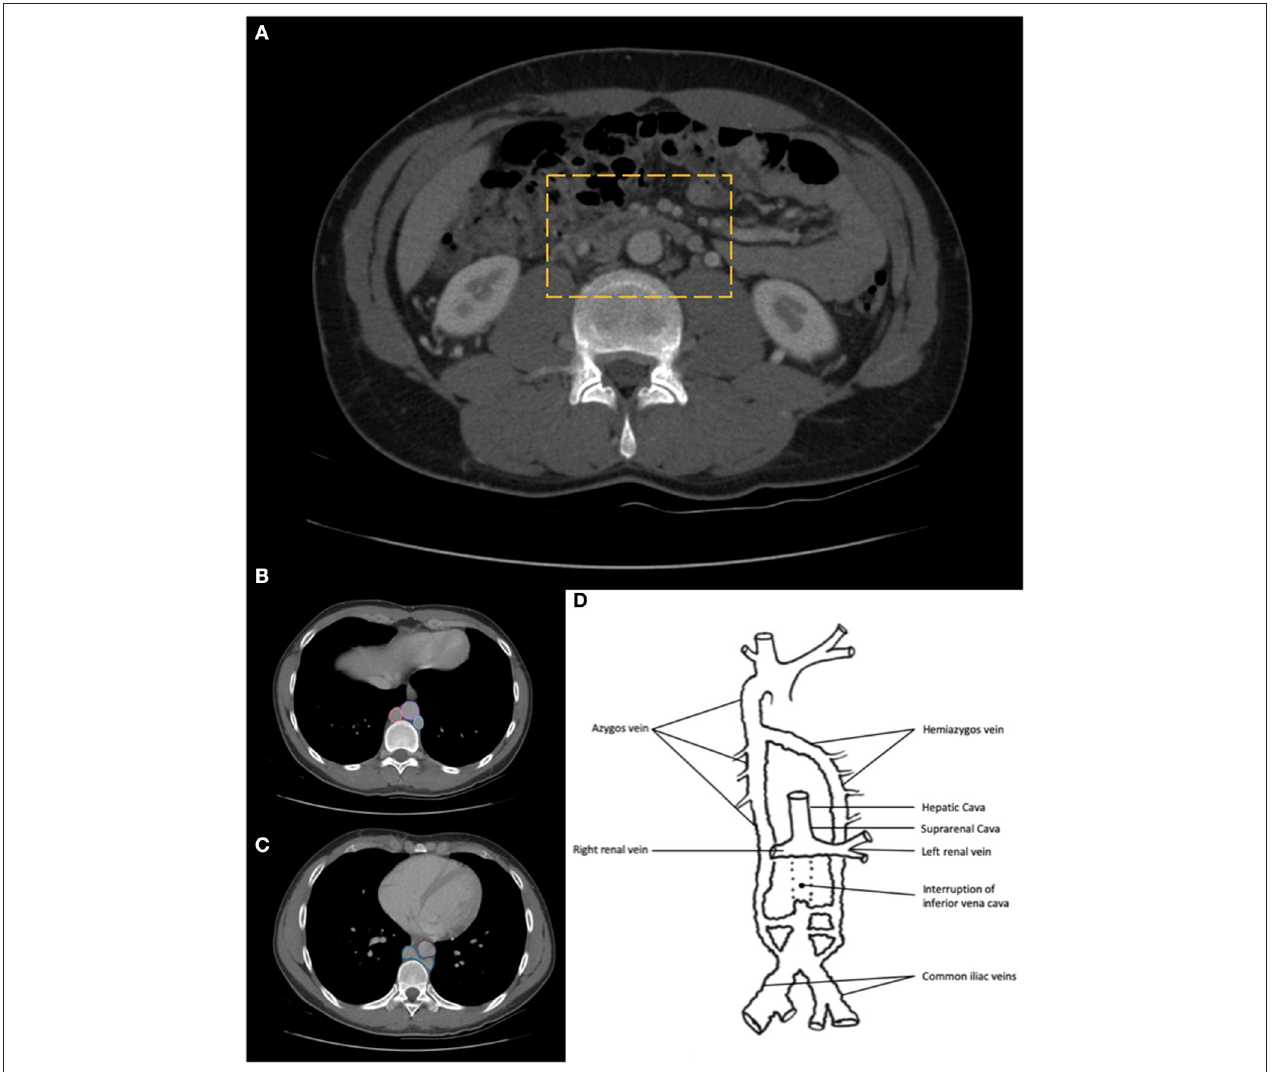
FIGURE 2 | (A) CT-angiography reveals the complete absence of the infrarenal part of inferior vena cava (IVC). (B) Thorax CT-angiography highlights the role of the dilatation of azygos and hemiazygos systems. (Pink circle: Azygos vein; Violet circle: Aorta; Blue circle: Hemiazygos vein); (C) Thorax CT-angiography slice indicates the level of azygos and hemiazygos coalescence (blue shape). Aorta is highlighted by a purple circle; (D) Depicting the scheme of the anatomical patient’s variant, highlighting the IVC agenesia and the development of the collateral venous drainage